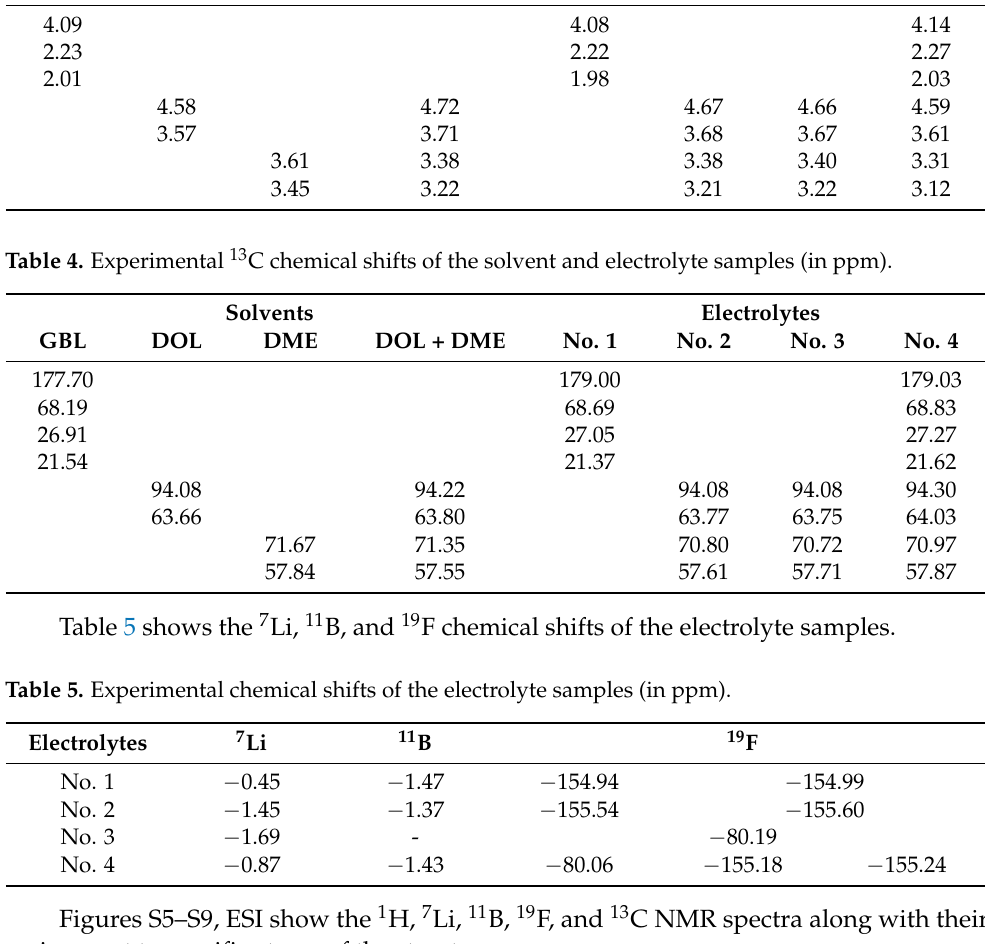
Table 3. Experimental 1 H chemical shifts of the solvent and electrolyte samples (in ppm). Solvents